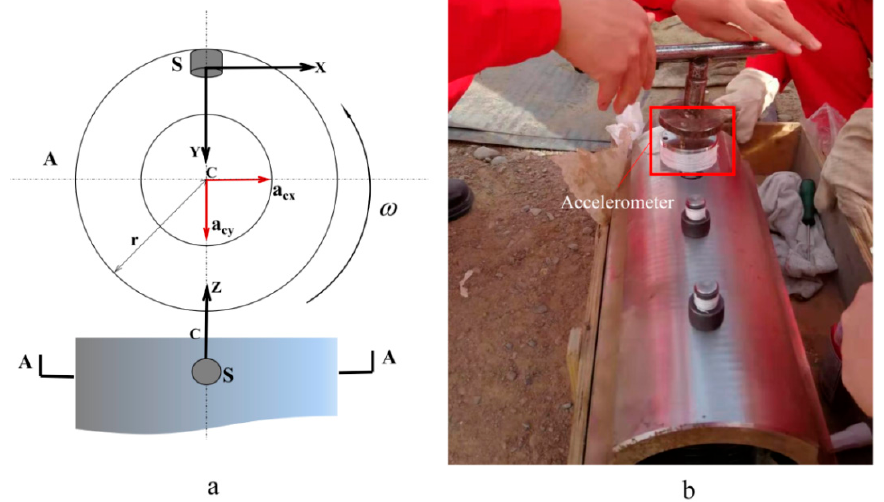
Figure 2. Schematic diagram of field installation of vibration measuring equipment. ( a ), c represents the center of the drill string, S is an orthogonal three-axis acceleration sensor, A is the cross section of the column, r is the radius of the drill string, X measures the acceleration of drill string tangential vibration, Y measures the radial vibration acceleration of the drill string, and Z measures the axial vibration acceleration of the drill string. ( b ) shows the sensor installation method on